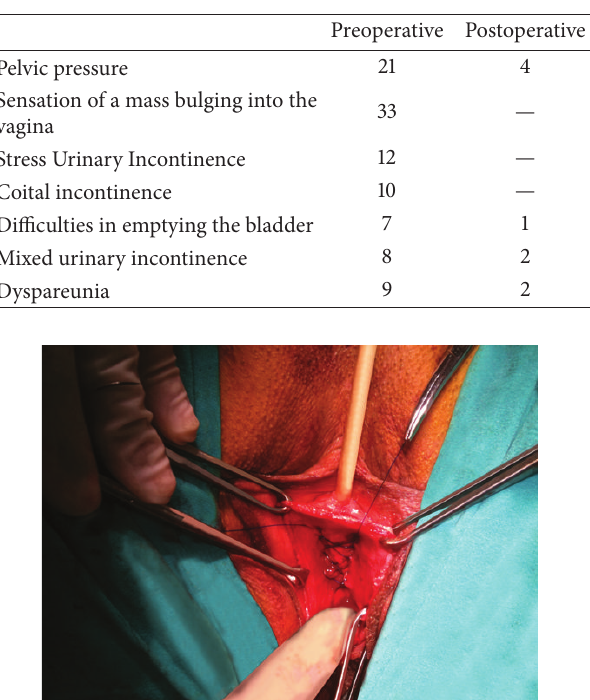
Table 3: Postoperative symptoms relief.